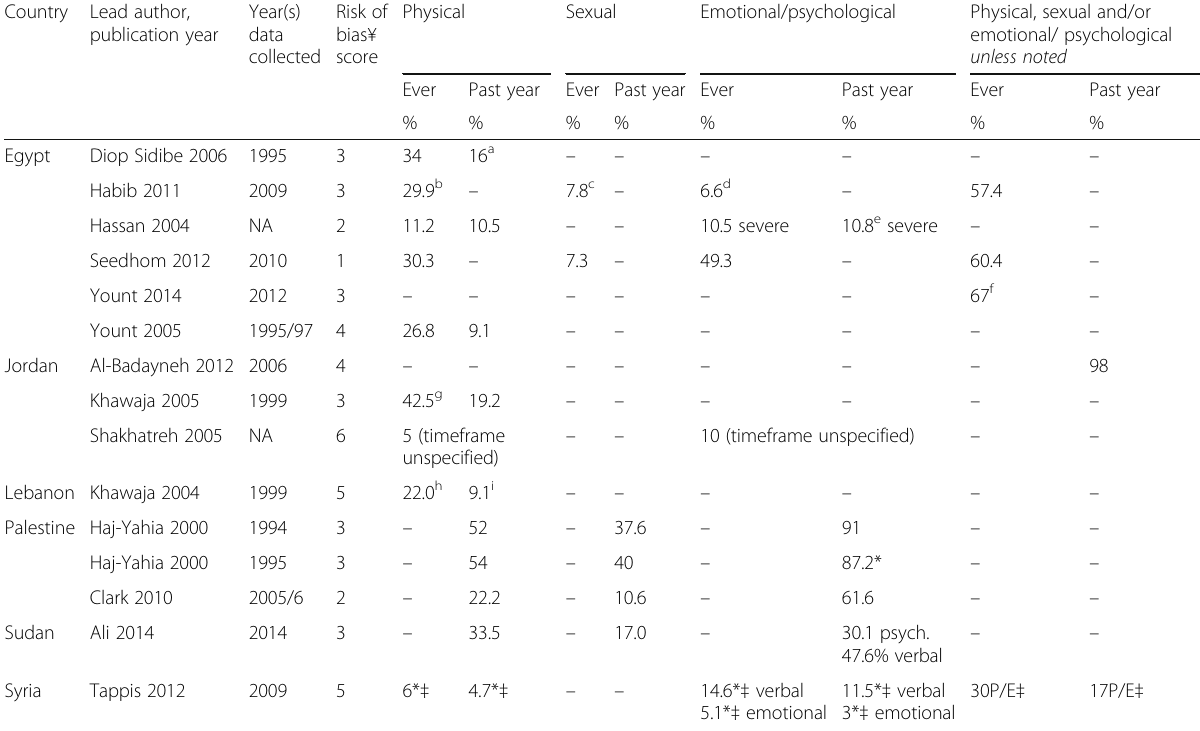
Table 4 Percentage of women reporting IPV, ever and past year, by type, population-based surveys from journals Country Lead author, publication year